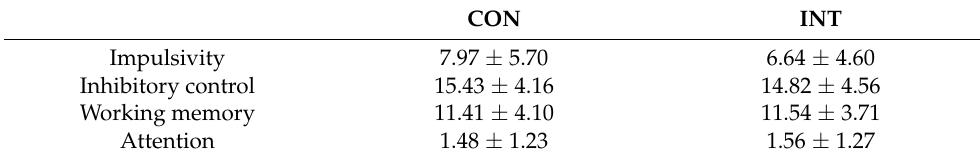
Table 3. Mean performance across both days on learning-associated tasks on CON and INT